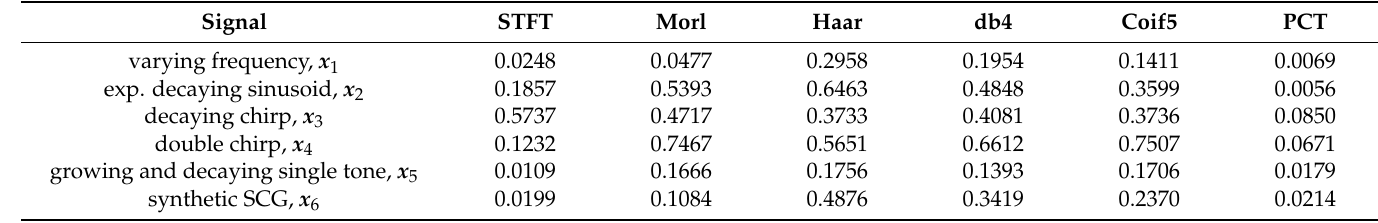
Table 4. Normalized root-mean-square error (NRMSE) between the actual and calculated IF for different TFD methods. Lower error values indicate more appropriate